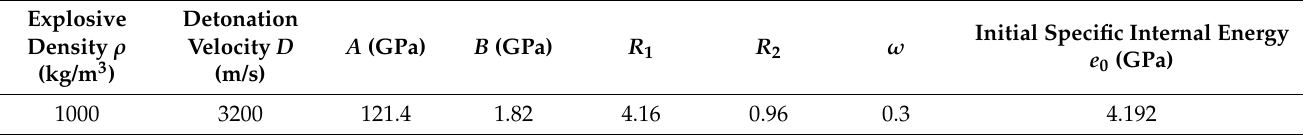
Table 3. Material properties of the